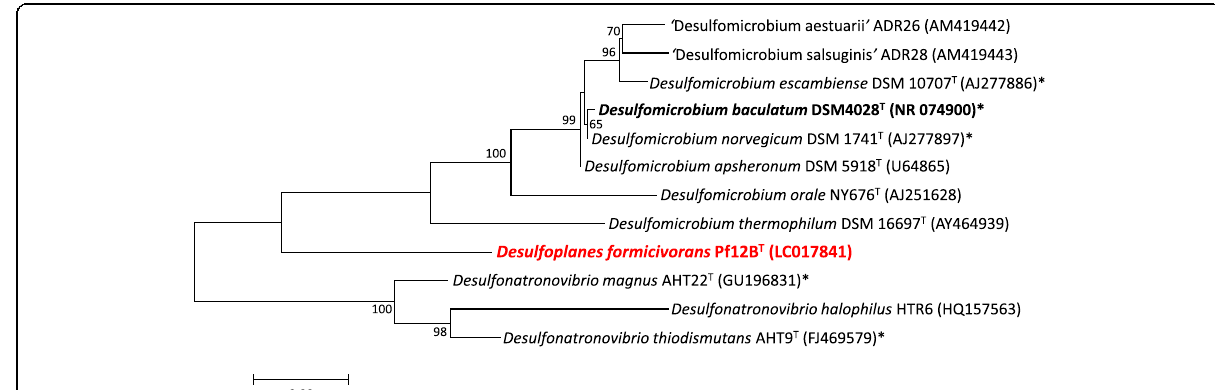
Fig. 2 Phylogenetic tree showing the relationship of D. formicivorans strain Pf12B T to other species of the family Desulfomicrobiaceae . Members of the genus Desulfonatronovibrio were used as the outgroup in this analysis. The tree was constructed by the Maximum-Likelihood method